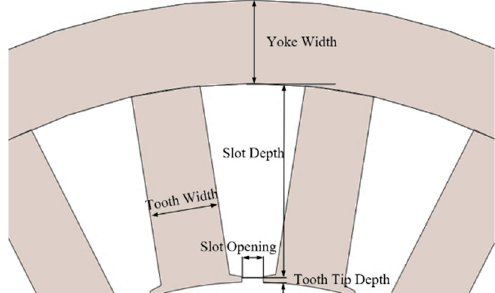
Figure 13. Stator structure schematic diagram.